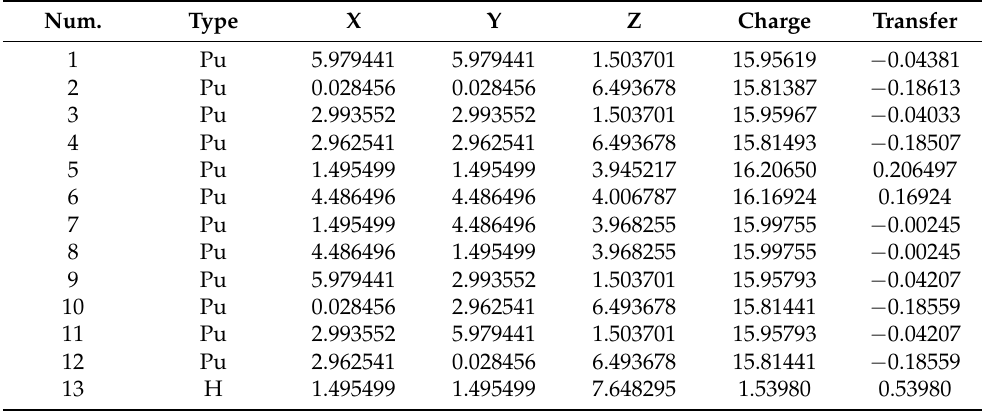
Table 5. Surface atomic charge transfer in δ -Pu system with H absorbed.